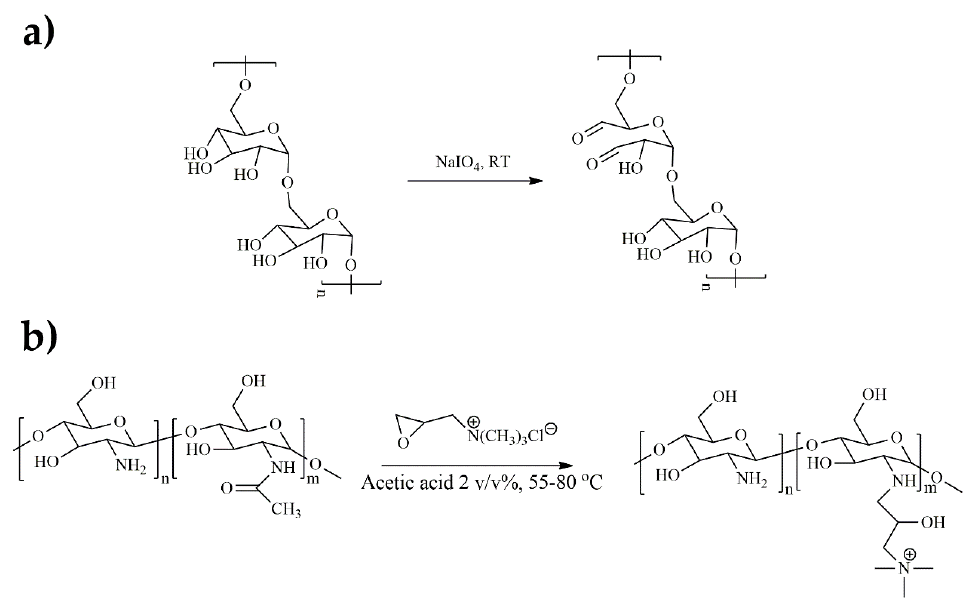
Figure 1. ( a ) Oxidation reaction of dextran using sodium periodate and ( b ) quaternization of chitosan by GTMAC (N-substitution).